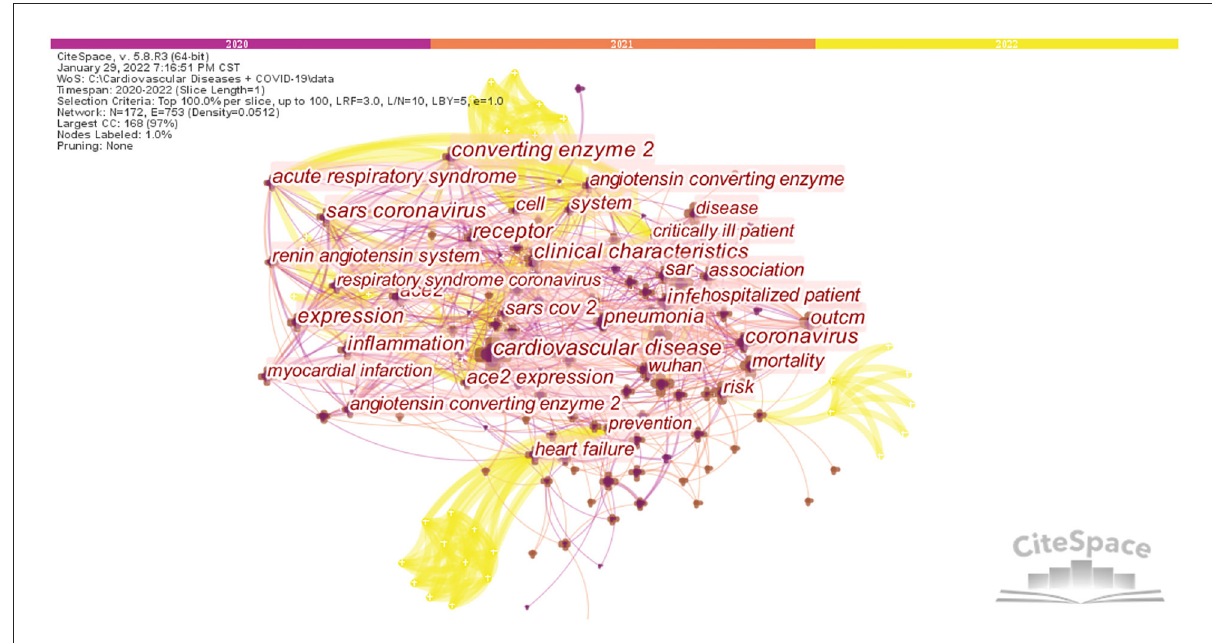
FIGURE7 Network of the main keywords in the studies of CVDs and COVID-19 research.